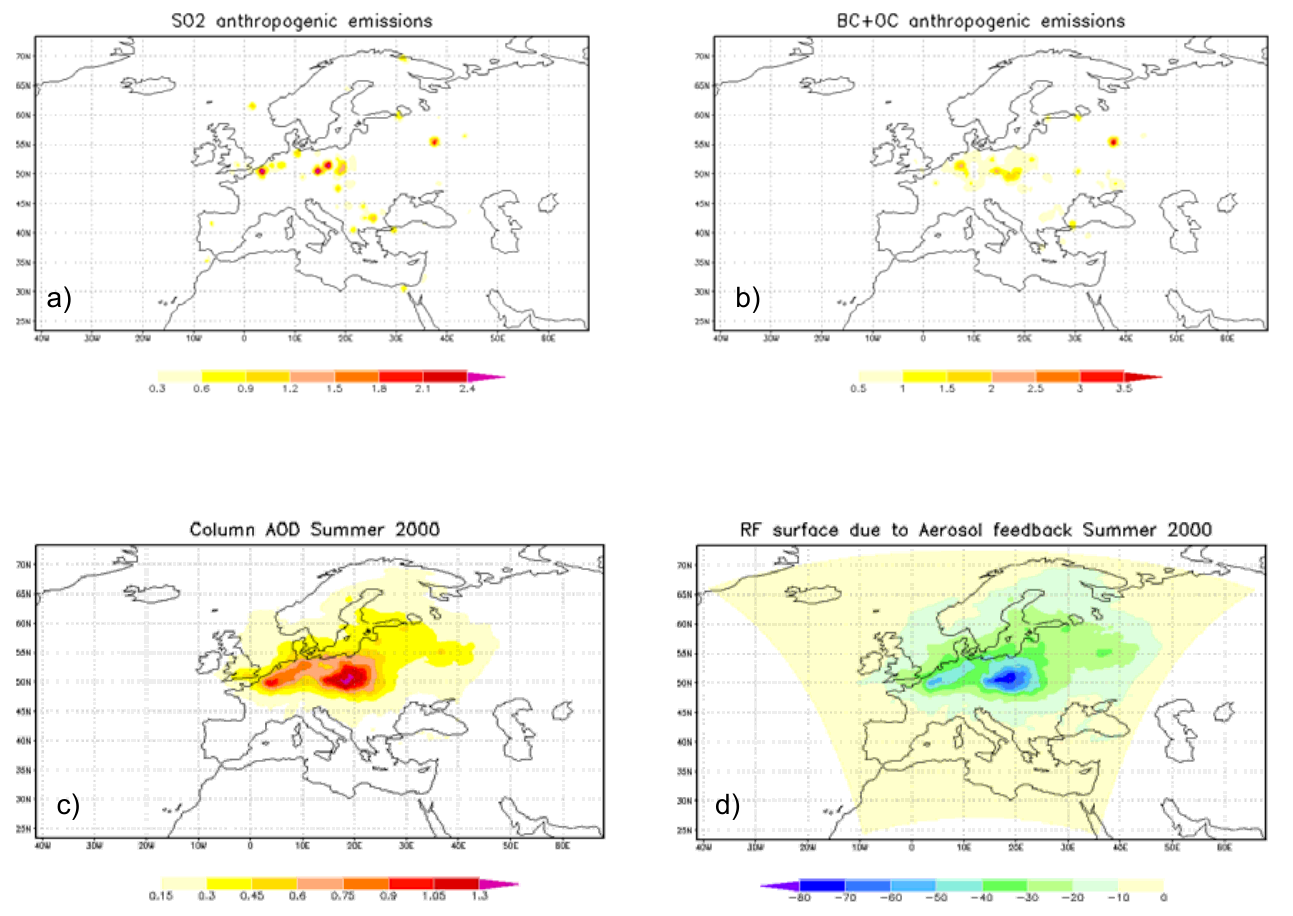
Fig. 2. Anthropogenic emission of (a) SO 2 (in 10 − 9 kgm − 2 s − 1 ) and (b) the sum of black and organic carbon (in 10 − 12 kgm − 2 s − 1 ) . Seasonal mean fields in summer of the year 2000 of (c) the aerosol optical depth and (d) the surface radiative forcing (in W/m 2 ) due to anthropogenic aerosols (carbonaceous particles and sulphates) obtained from the RegCM3/aerosol